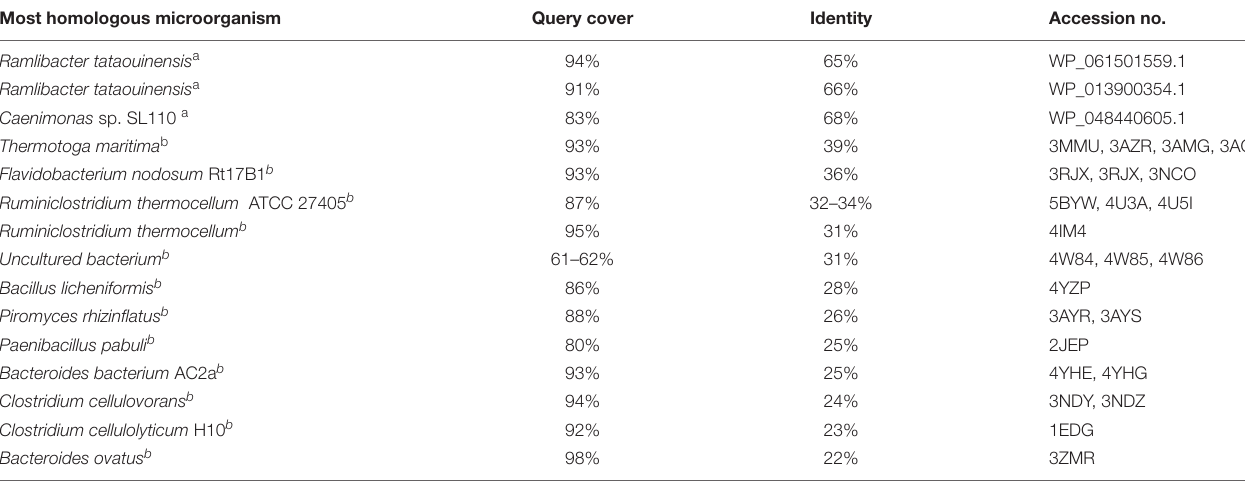
TABLE 1 | Amino acid sequence CelRH5 homology to other sequences deposited in database established using BLASTp. Most homologous microorganism Query cover